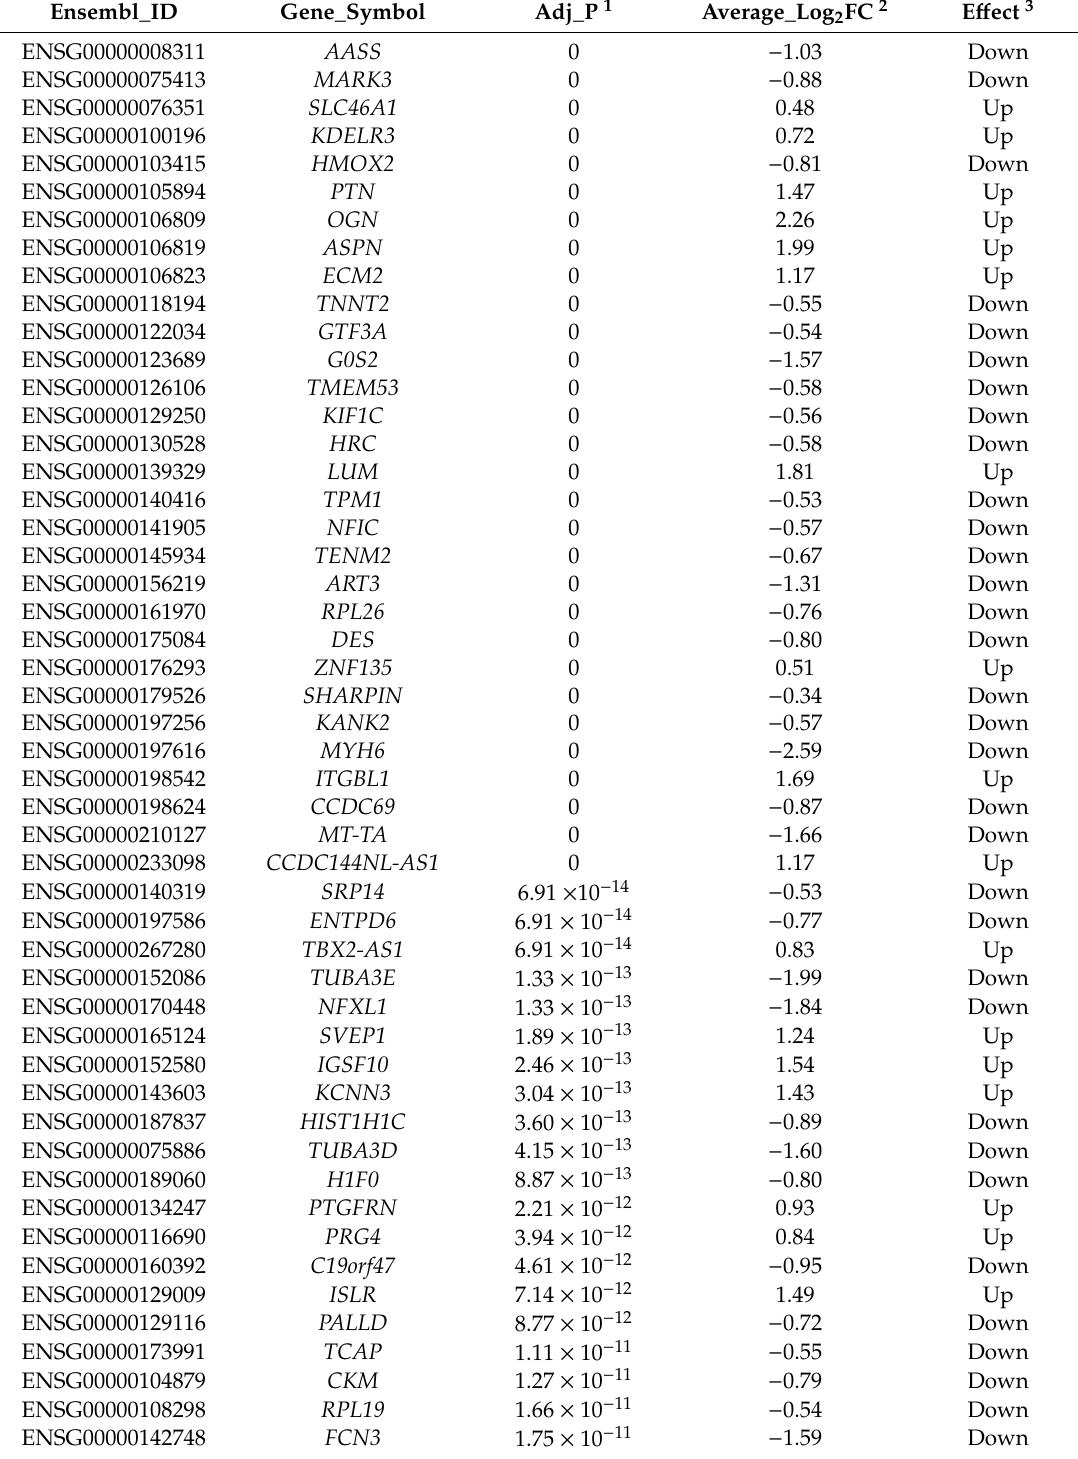
Table 2. Top 50 DEGs identified in